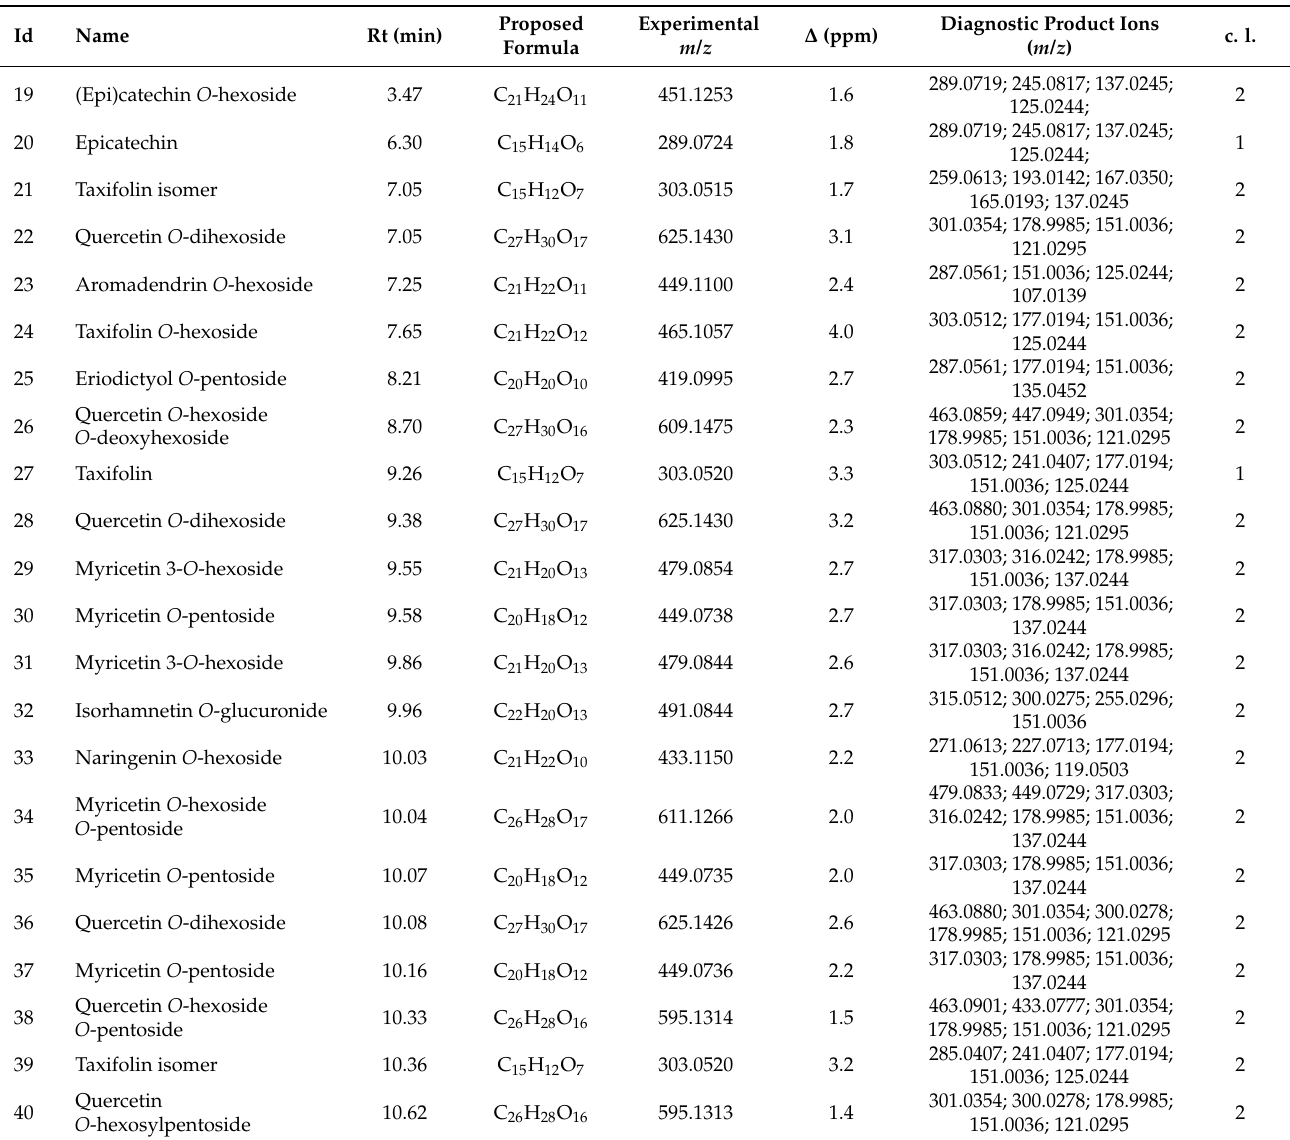
Table 2. Retention times (Rt, min), proposed formulas, experimental m/z , accuracy ( ∆ , ppm), main diagnostic experimental product ions, and confidence level of the identification (c. l.) of the 87 tentatively identified flavonoids in Disterigma alaternoides extract in ESI( −